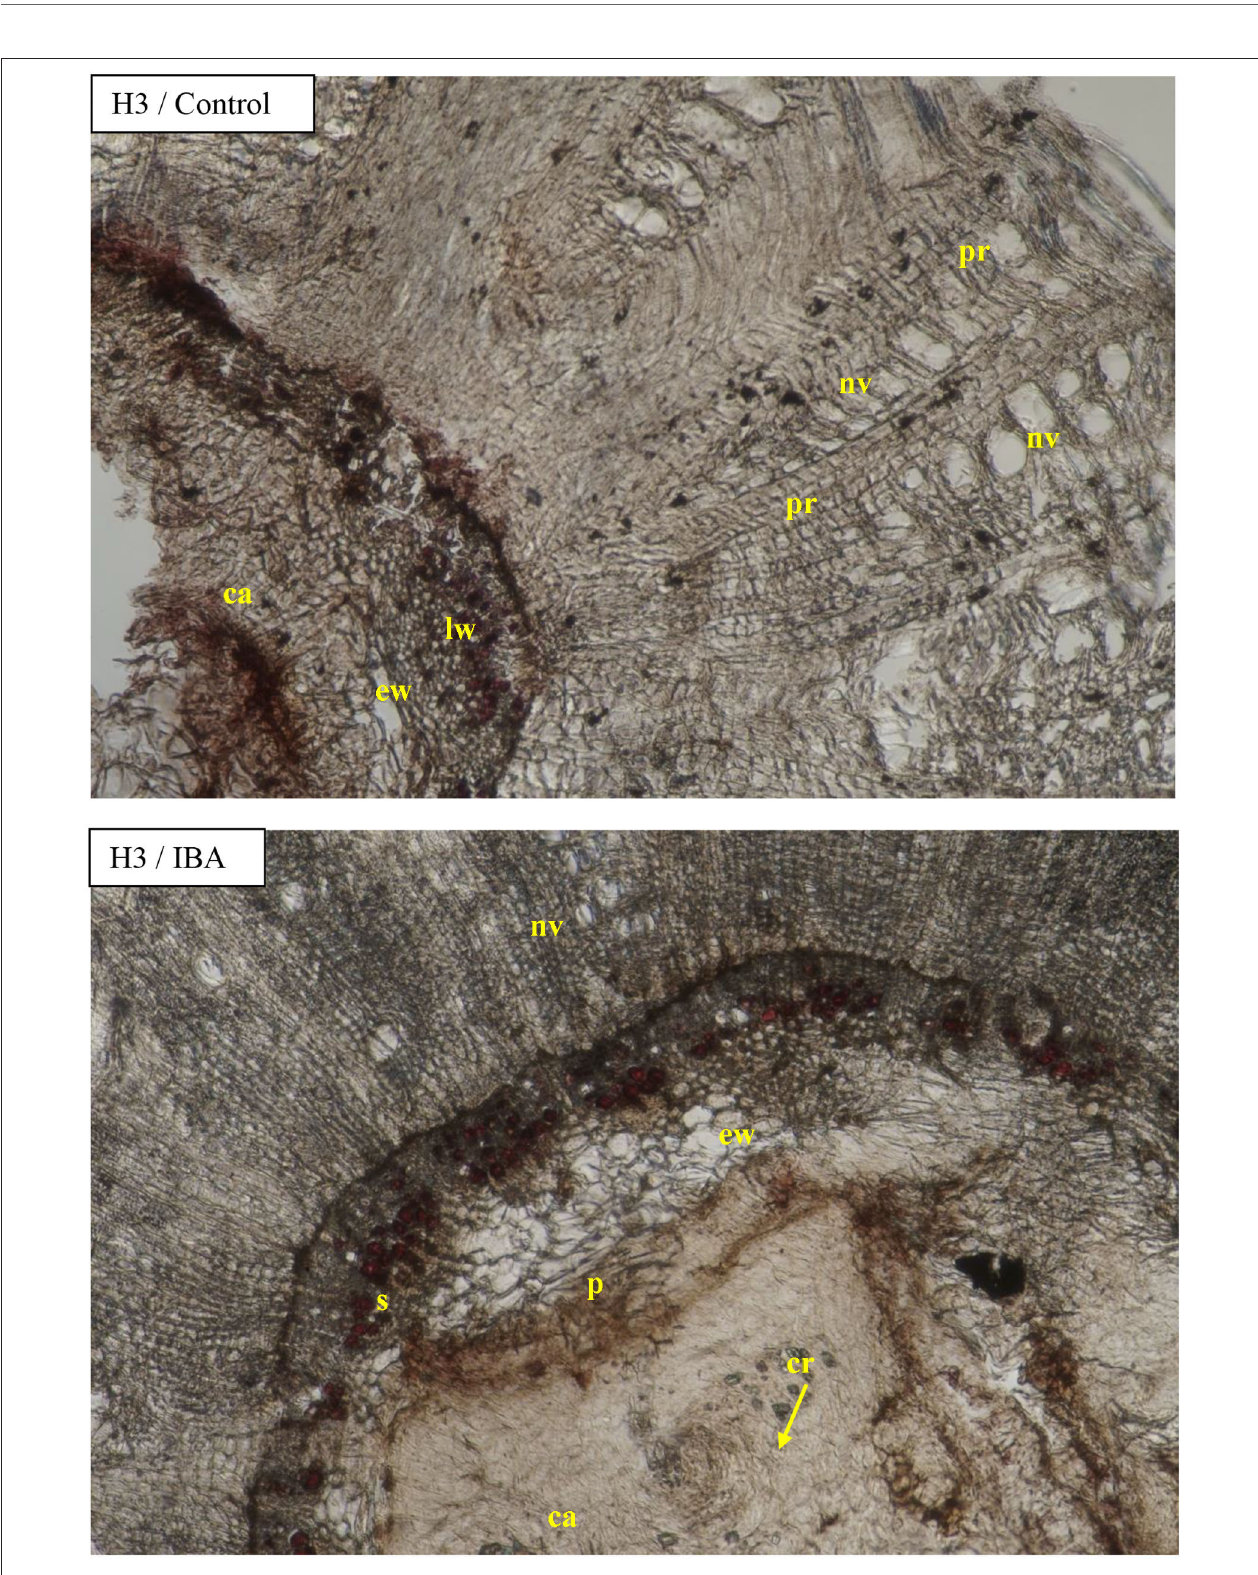
FIGURE 7 | Transverse sections of the shoots after 25 days of the process of rhizogenesis rooting in Rosa “Hurdal” in phenological stages in BBCH scale (Meier et al., 2009) H3 − 69 629 (end of flowering of the second-order stem—all petals have fallen) in control—the control cuttings without rooting enhancers and after treatment IBA—Ukorzeniacz A aqua (0.4% IBA). Designation of signs: ca, callus; c, cambium; co, cortex; cr, crystals; p, pith; pr, pith rays; s, sclerenchyma; nv, new vessels/vascular bundles; ew, earlywood; lw, latewood; fr, forming root.